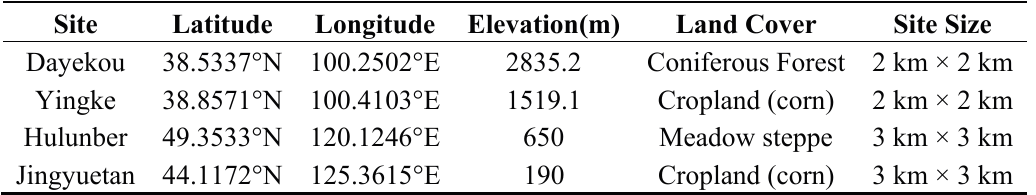
Table 1. Validation site